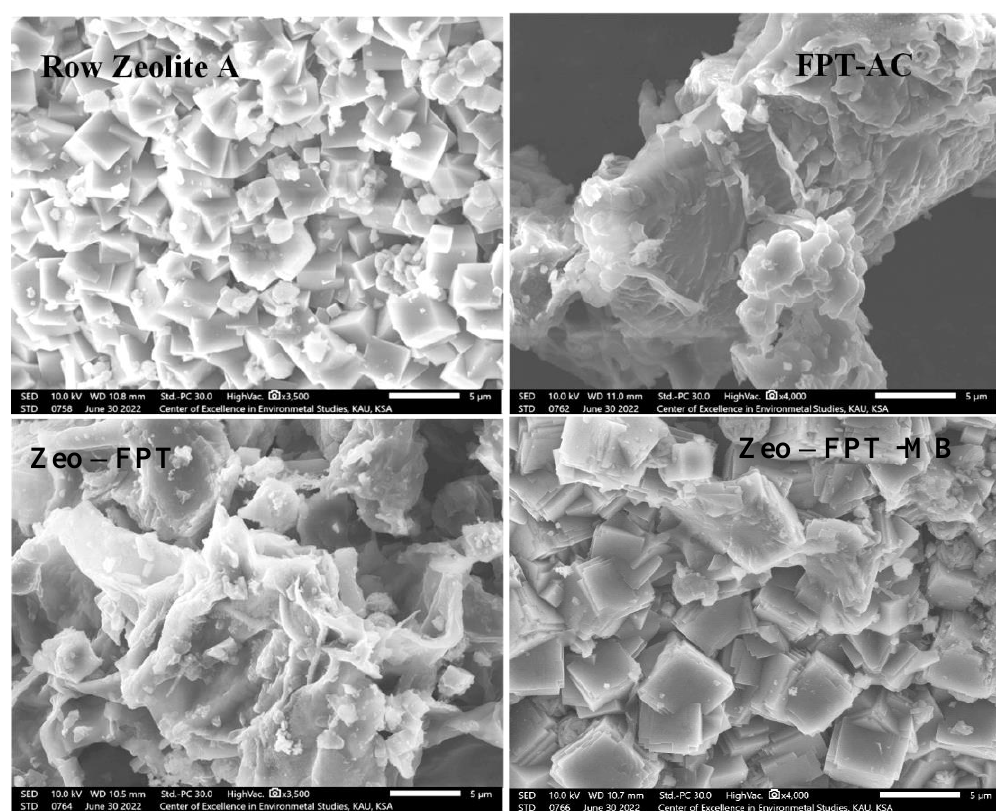
Figure 2. The SEM images of synthesized pure zeolite A, FPT-AC, Zeo-FPT composite before sorption, and Zeo-FPT-MB after sorption.